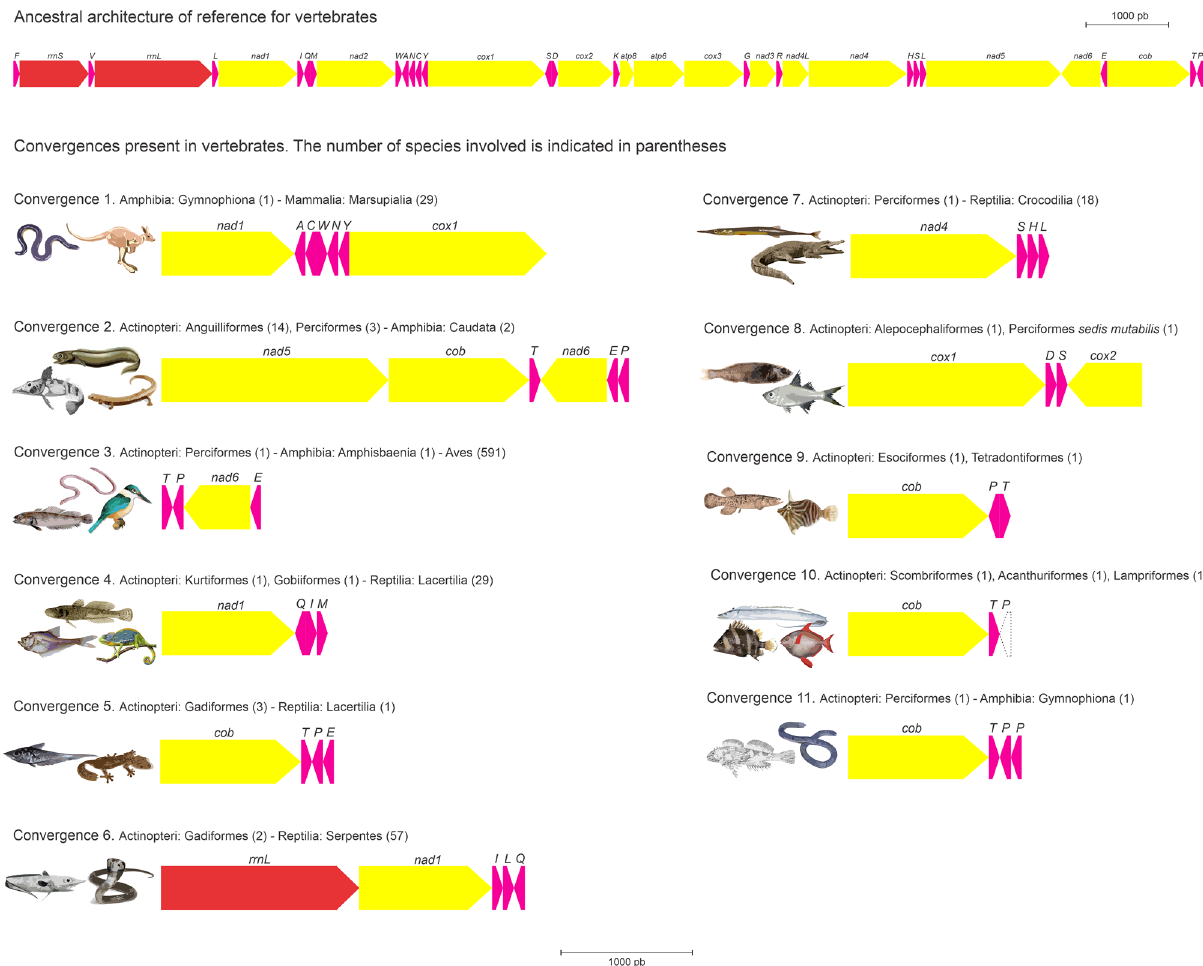
Figure 3. Evolutionary convergence of mitochondrial gene order rearrangements. This shows only the subsets that are rearranged; all other genes share the ancestral arrangement. Arrows show transcriptional orientation. tRNA-encoding genes are labeled with the one-letter code for the corresponding amino acid. In parentheses are the number of species involved in the